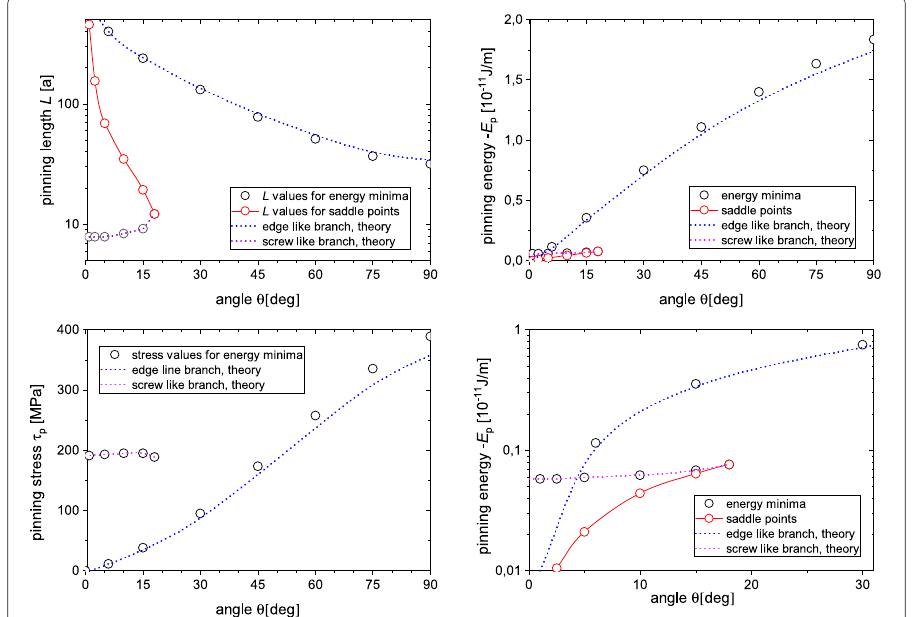
Fig. 5 Pinning length (left, top), pinning stress (left, bottom) and pinning energy (right top and bottom) as functions of dislocation orientation angle, calculated for an equiatomic MgAl solid solution with parameters given in Table 1. Full circles indicate minima or saddle points determined from the full energy functional using a saddle point search, dashed lines correspond to maxima and minima computed from